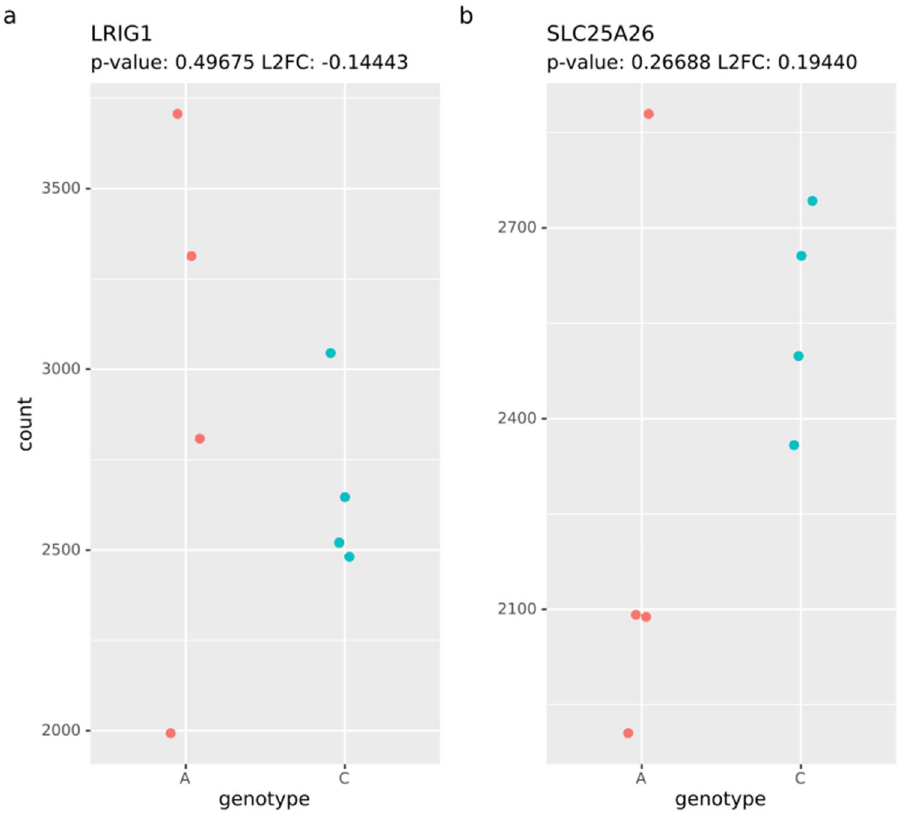
Figure 1. Expression of LRIG1 and SLC25A26 in cell lines. Normalized read counts for ( a ) LRIG1 and ( b ) SLC25A26 . The low-risk variant (A) to the left and high-risk (C) to the right. Each point is the aggregate for the four